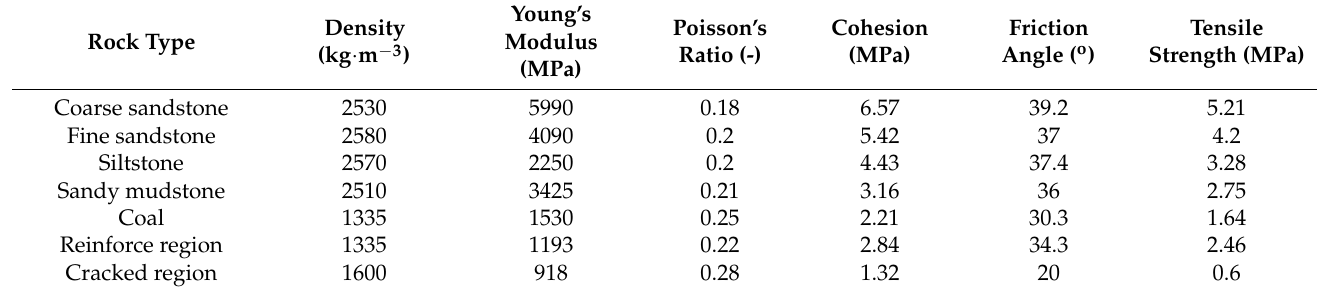
Table 3. The physical and mechanical parameters of